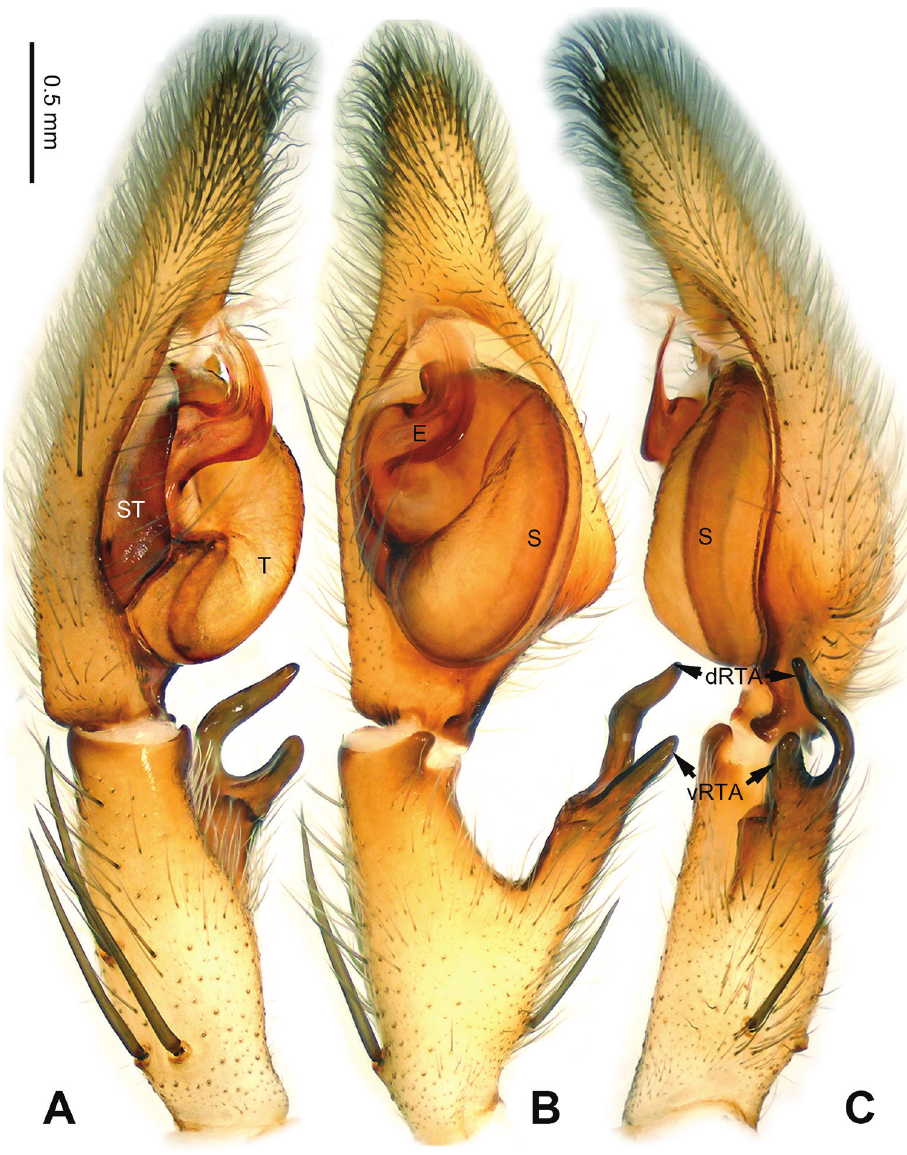
Figure 1. Pseudopoda chayuensis Zhao & Li, sp. n., right palp of male holotype, horizontally flipped for the sake of comparison. A Prolateral view B Ventral view C Retrolateral view. Scale bar equal for A, B, C .